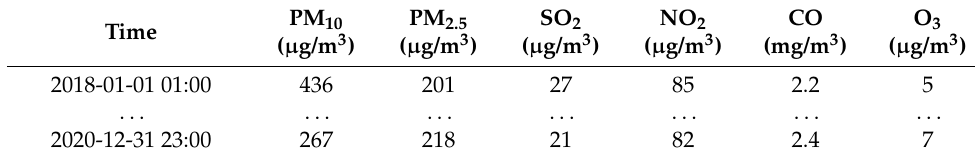
Table 1. Air-pollutant-data examples at the station of Xincheng Central Square in Xi’an from 2018 to 2020. Time